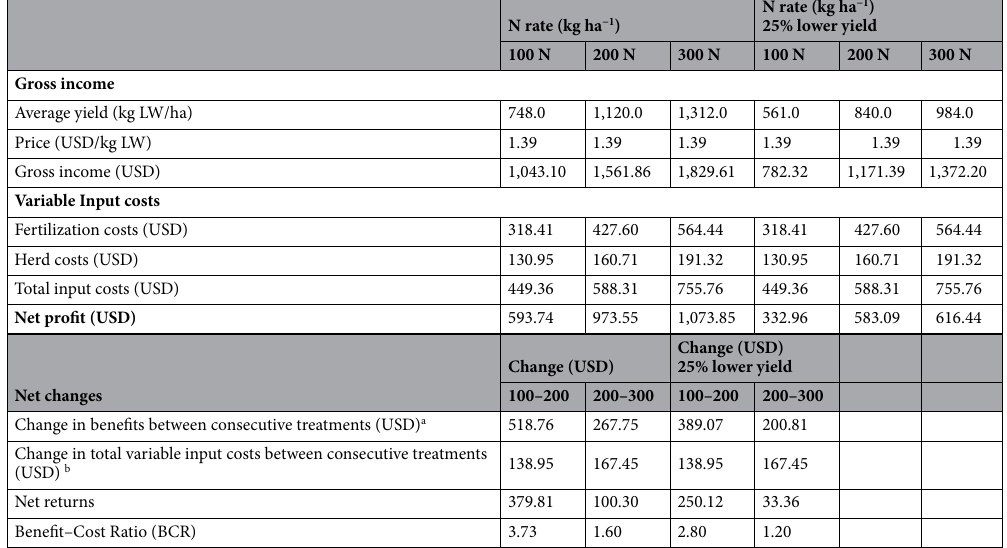
Table 7. Partial budget for beef production on Mombaça guinea grass at increasing N-fertilizer rates 1 , based on experimental data and in an alternative scenario (25% reduction in yield). 1 Currency exchange 1.0 BRL = 0.258 USD (2018/2019 average, based on 26 observations over this period. Source: https:// www. xe. com/ curre ncyco nvert er/). a Change in gross income (benefits), when comparing N200 to N100, and N300 to N200, in this order. b Change in total variable costs, when comparing N200 to N100, and N300 to N200, in this order.